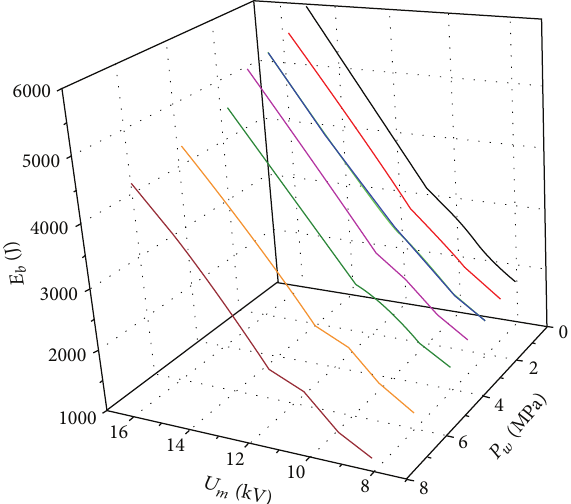
Figure 8: Plot of charging voltage ( 𝑈 𝑚 ) and breakdown energy ( 𝐸 𝑏 ) under different hydrostatic pressure ( 𝑃 𝑤 ) conditions.